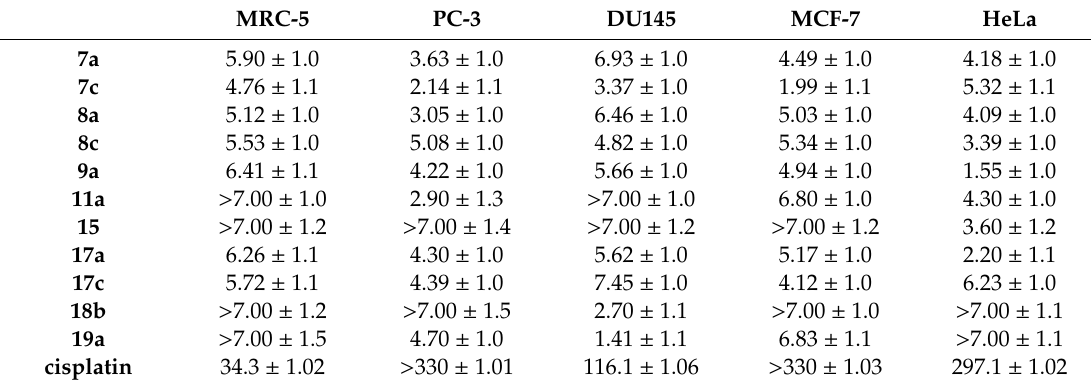
Table 3. IC 50 values ( µ M ± SD) of the selected compounds determined on various cancer cell lines and on non-cancerous MRC-5